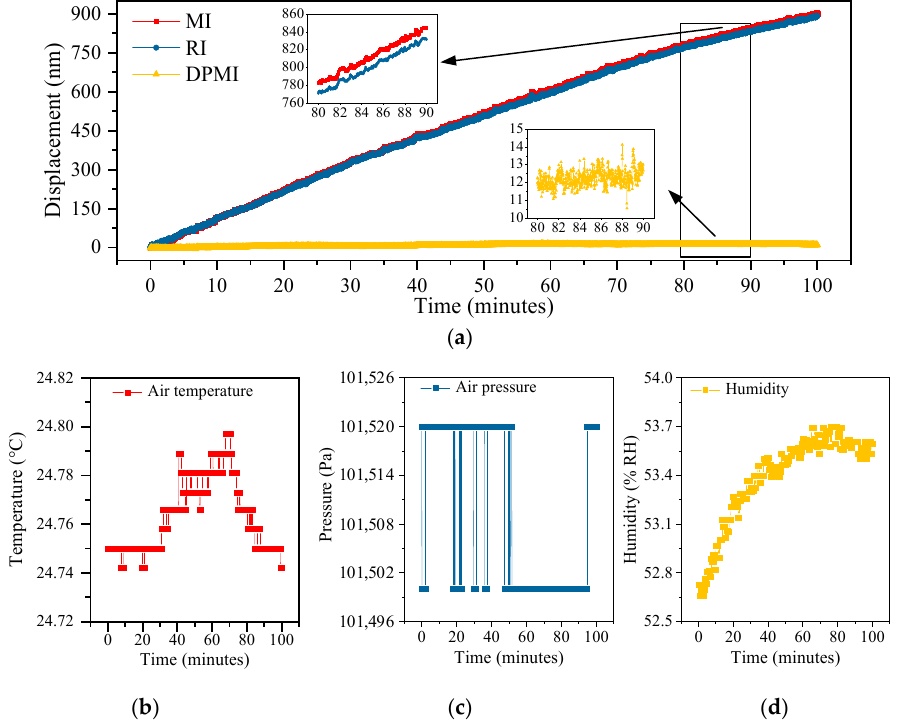
Figure 4. Experimental results of differential displacement stability and environment parameter drift within 100 min: ( a ) displacement; ( b ) air temperature; ( c ) air pressure; ( d )